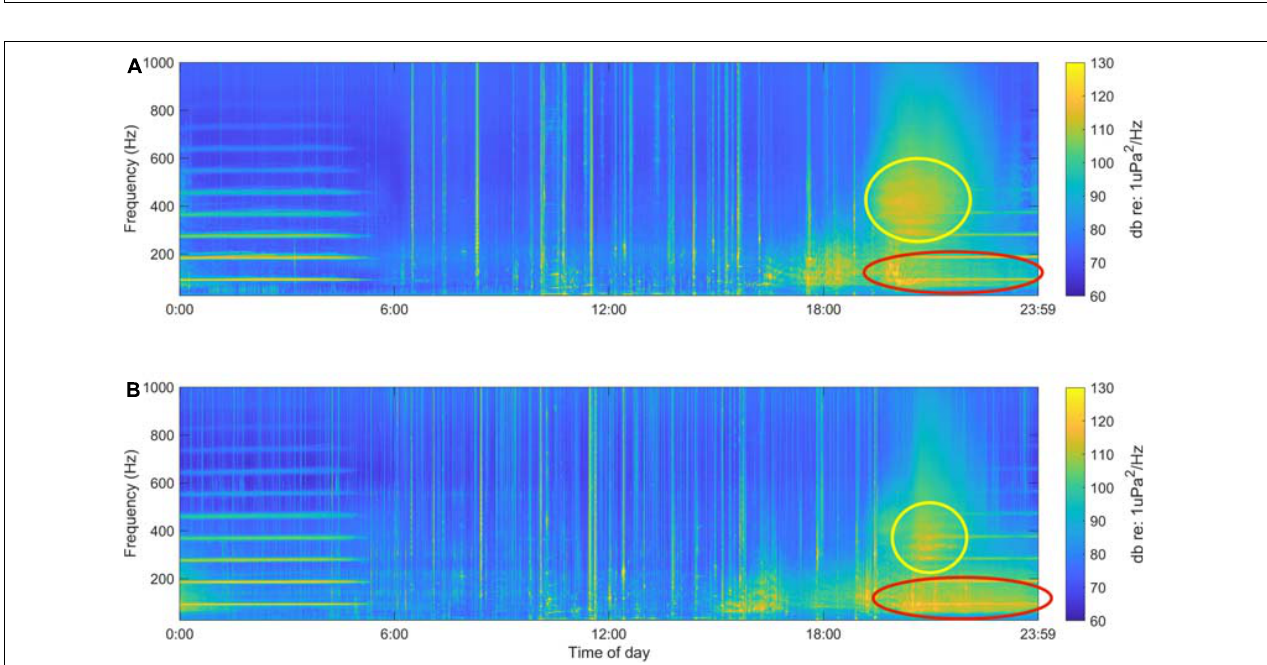
FIGURE 2 | Example long-term spectral average plots for a 24 h period (midnight Aug ust 21st to midnight Aug ust 22nd, 2017) at Site A (A) and Site B (B) . The two putative fish choruses are highlighted by the yellow and red ovals.